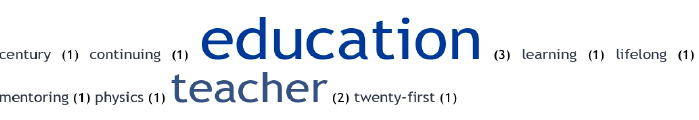
Figure 8. Word cloud on retired teachers.